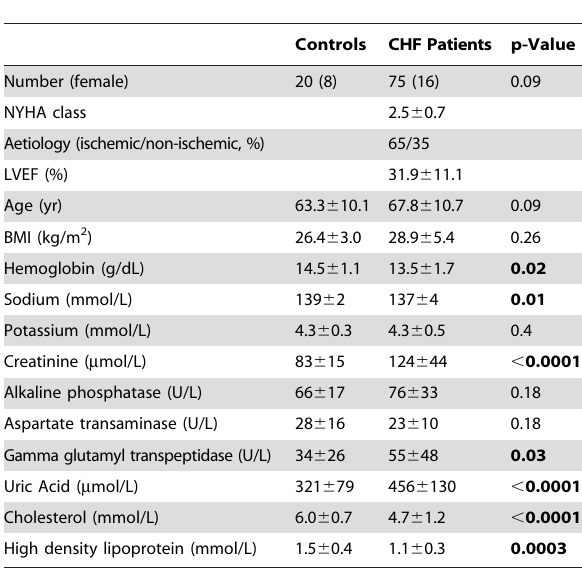
Table 1. Baseline data for control subjects and patients with